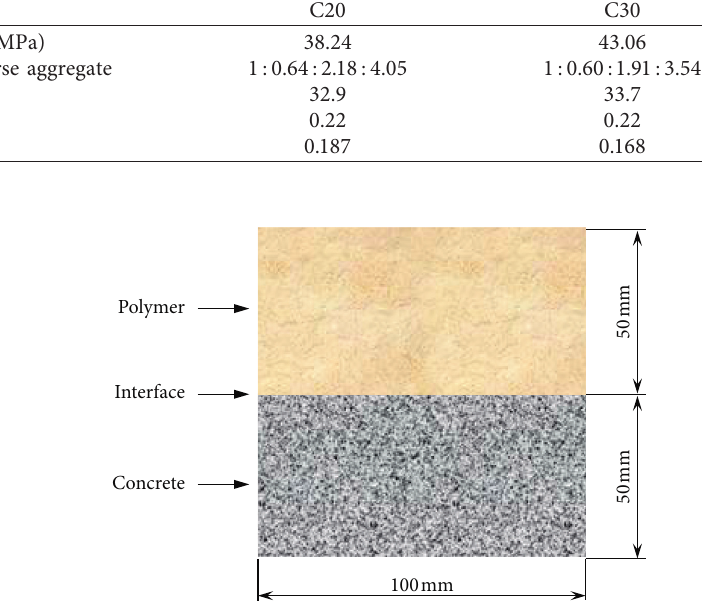
Figure 2: Schematic of